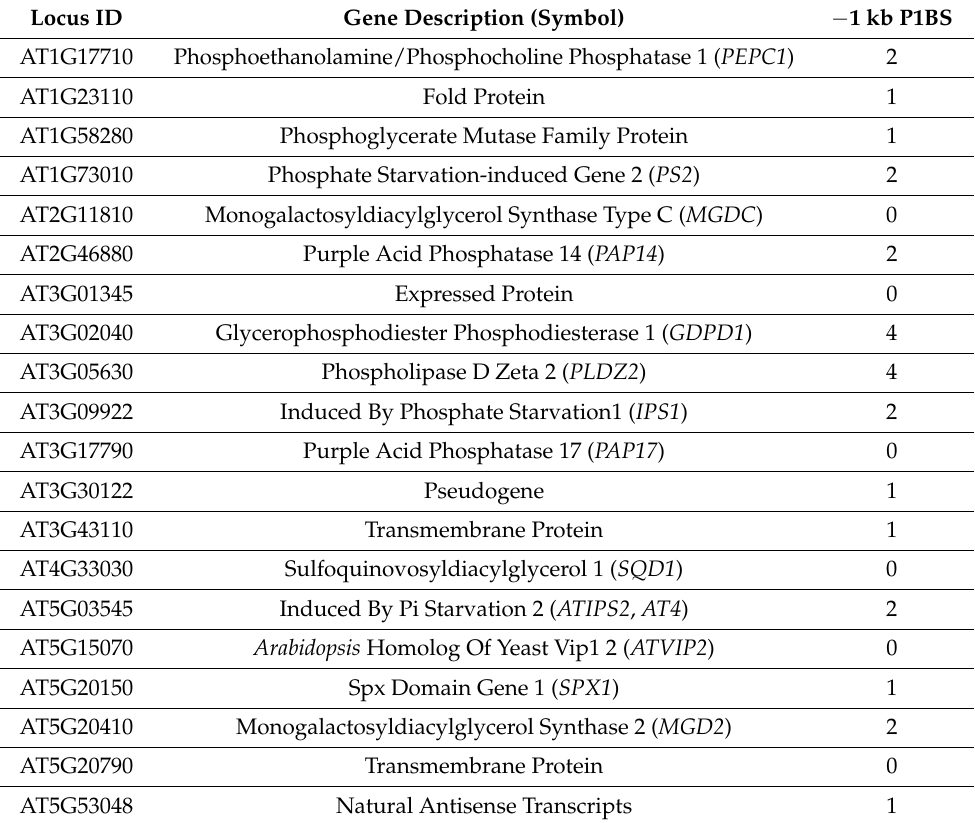
Table 1. Description of conserved downregulated genes in vip double mutants. Many of these genes were found to be associated with phosphate starvation responses. Promoter motif analysis found one or more PHR1-binding sequences (P1BS, GnATATnC) to be present in the 1kB putative promoter region upstream of 14 of these